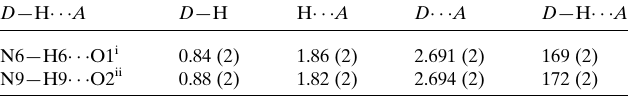
Table 2 Hydrogen-bond geometry (A˚ , (cid:4)